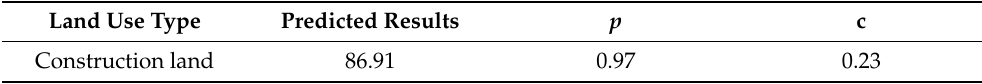
Table 2. Projected land use carbon emission factor in Sanmenxia city in